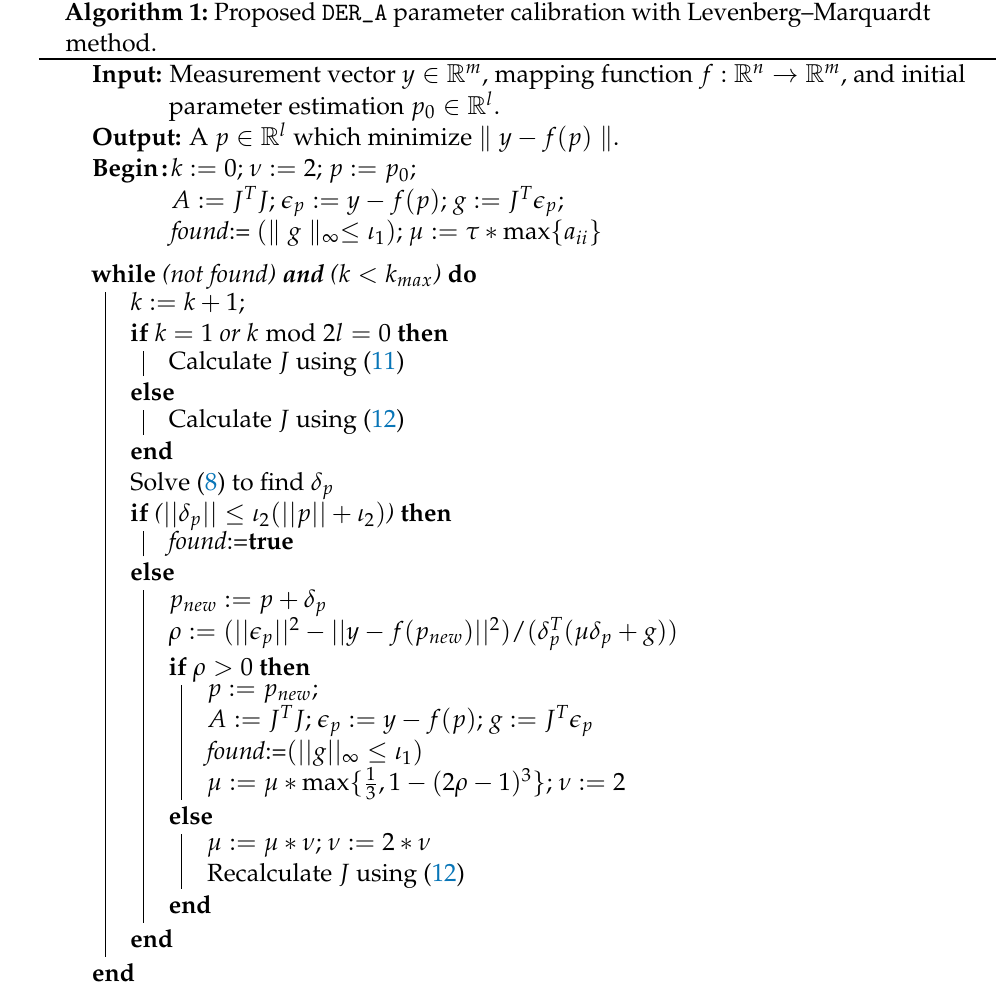
Algorithm 1: Proposed DER_A parameter calibration with Levenberg–Marquardt